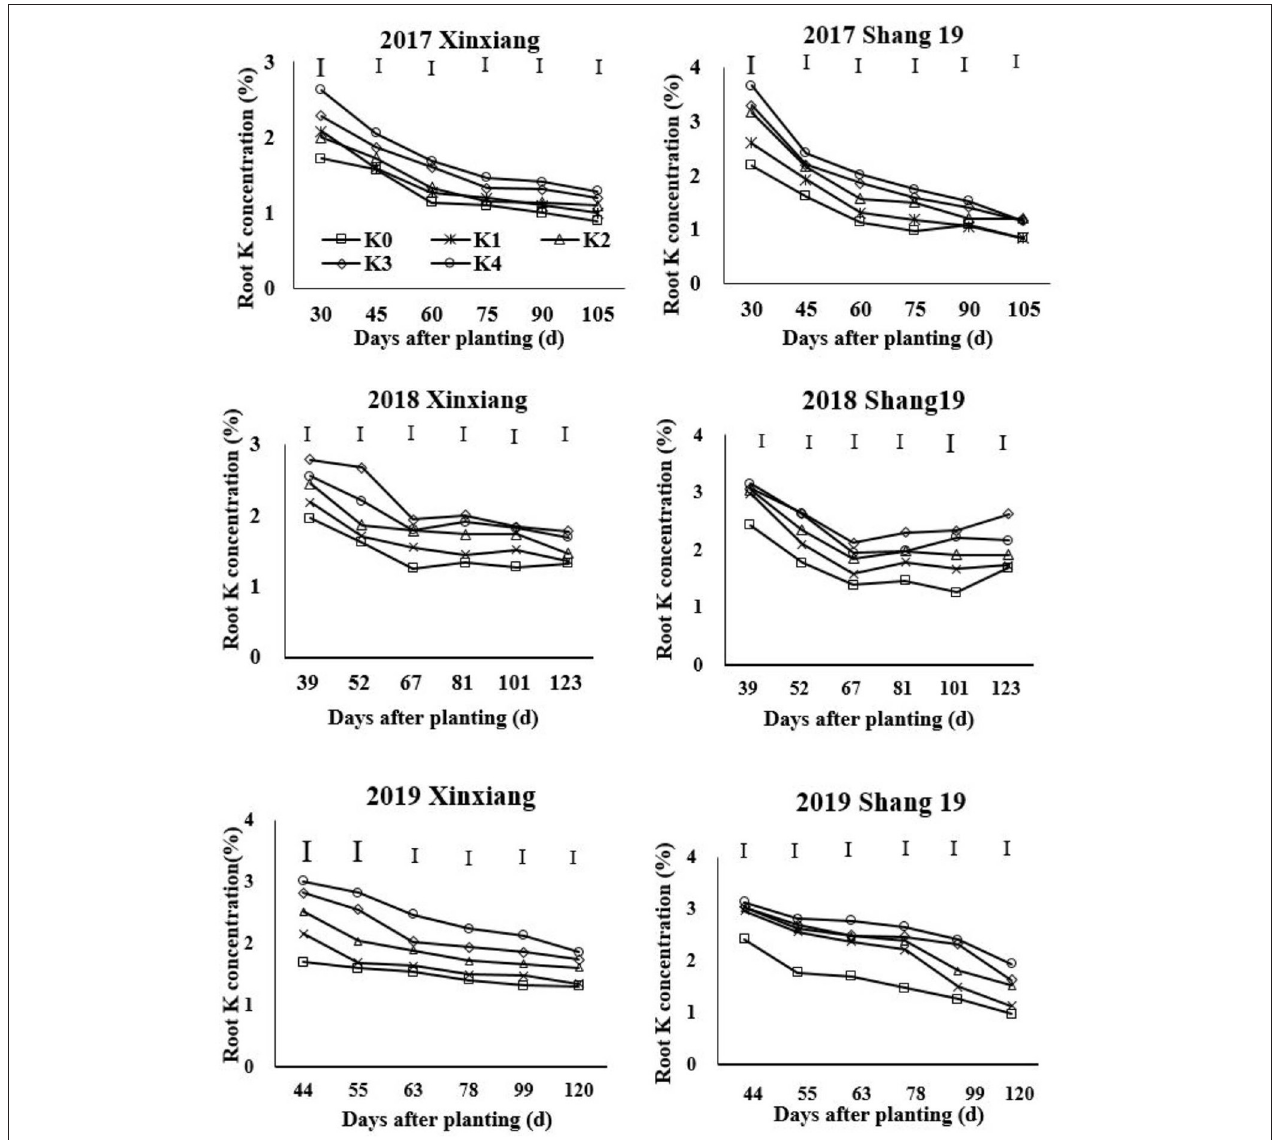
FIGURE 3 | Changes in K concentration in sweet potato roots with time under different K fertilization